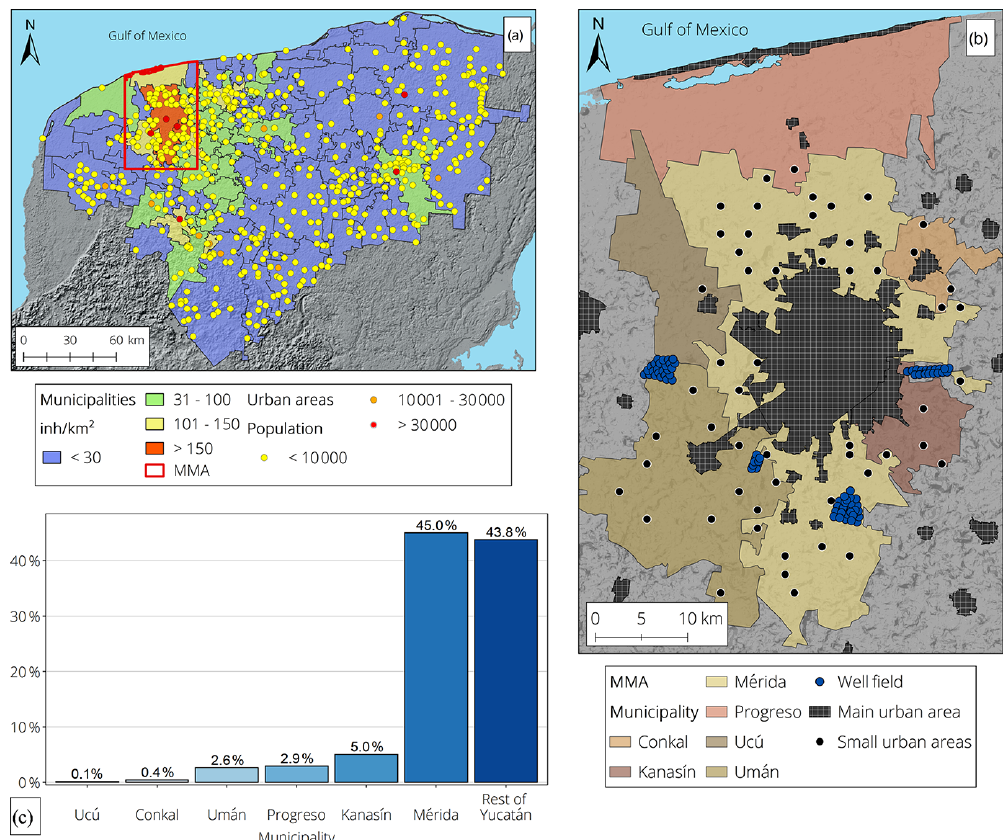
Figure 3. Administrative and anthropogenic characteristics in Yucatán. (a) The hydrogeological division and population density by mu- nicipality (inh: inhabitant). (b) The MMA and the main urban areas. (c) Comparison of water consumption for the MMA and the rest of Yucatán.